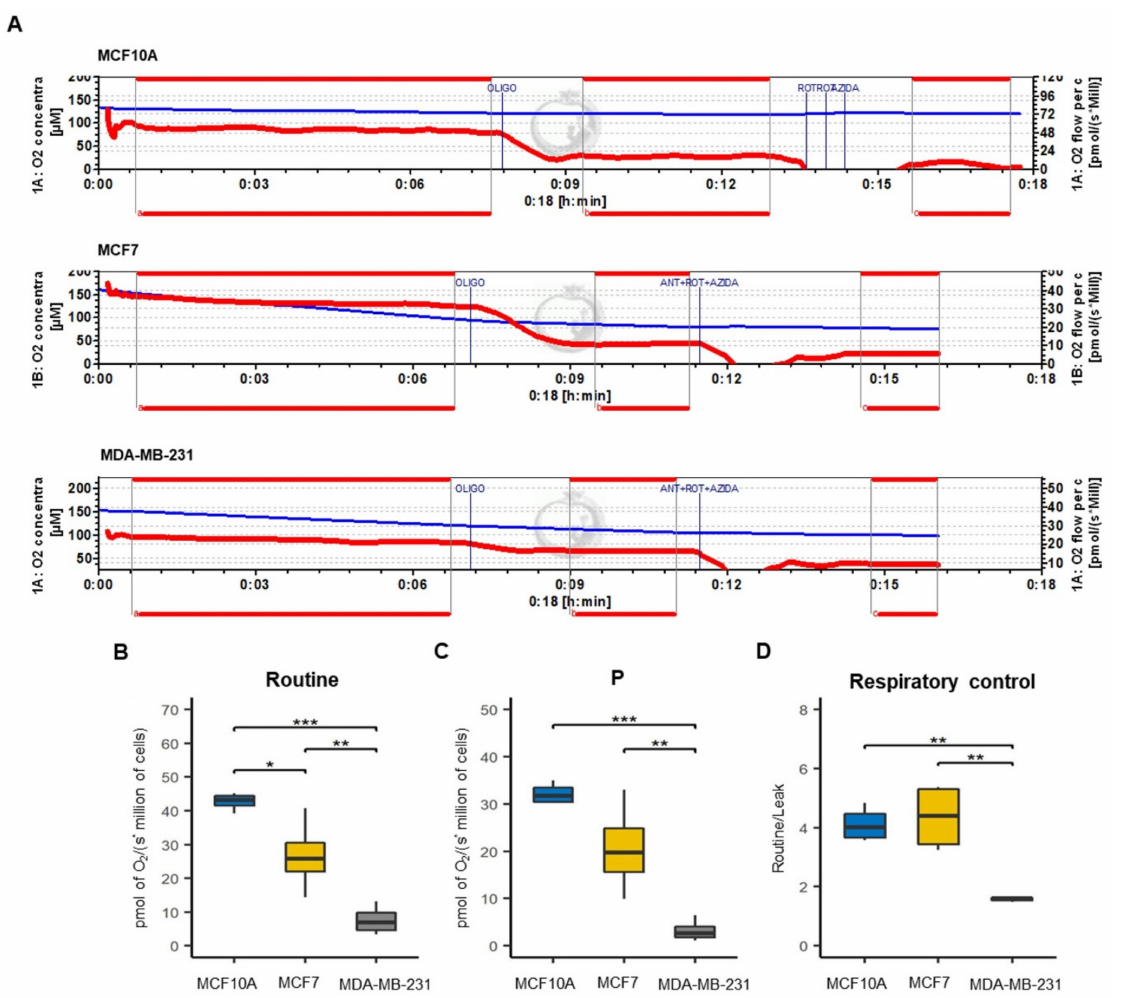
Figure 6. Mitochondrial respiratory efficiency of breast cancer cell lines. ( A ) Schematic representation of O 2 consumption rate by addition in order of OLIGO (oligomycin) and ANT + ROT + AZIDA (antimycin A plus rotenone plus sodium azide) inhibitors to determine the respiratory parameters in MCF10A, MCF7 and MDA-MB-231 cell lines. The blue line shows the oxygen concentration in the chamber while the red line indicates the oxygen consumption rate. ( B ) Cellular routine respiration (Routine), that correspond to oxygen consumption of the cells. ( C ) Respiration associated with oxidative phosphorylation (P); ( D ) respiratory control (RC) calculated as routine/leak ratio. All parameters were corrected by subtracting the non-mitochondrial respiration, obtained by the addition of ANT + ROT + AZIDA. The data are presented as mean ± SD, n = 3–4. * p < 0.05, ** p < 0.01, *** p <